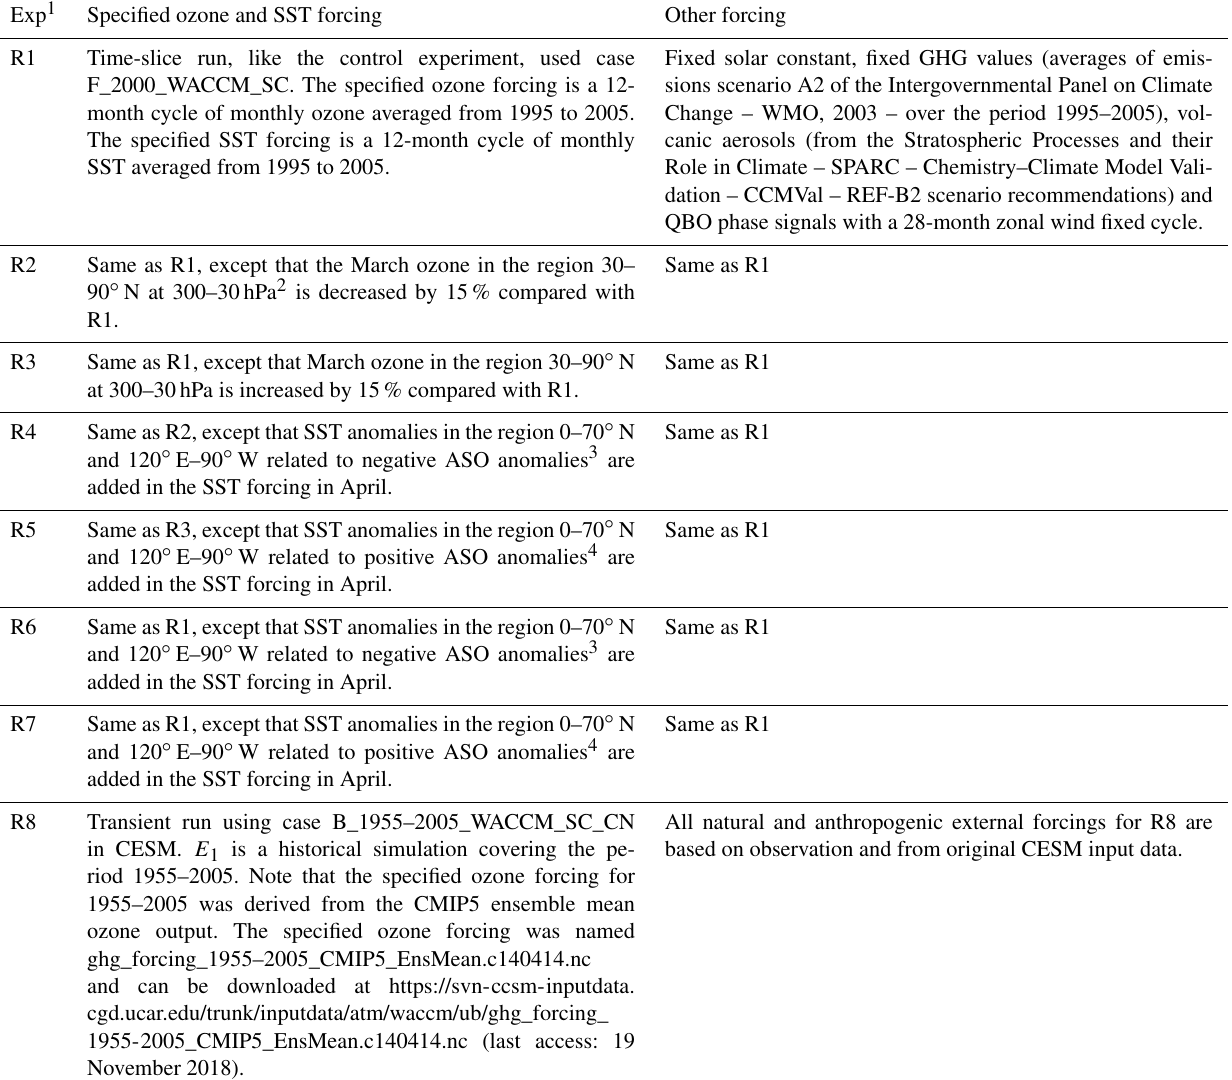
Table 1. The Community Earth System Model (CESM) WACCM4 experiments with various specified ozone and SST